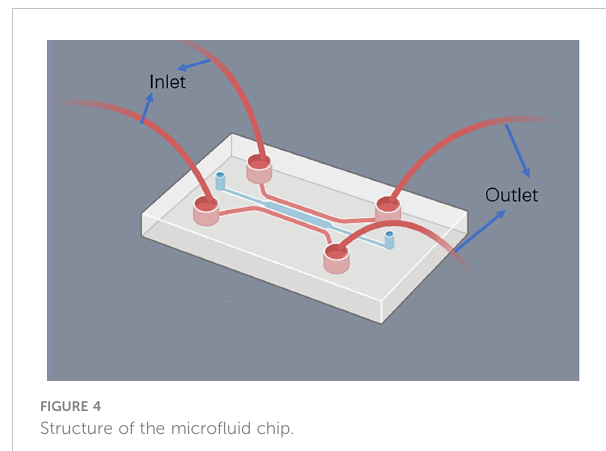
FIGURE 4 Structure of the micro fl uid chip.